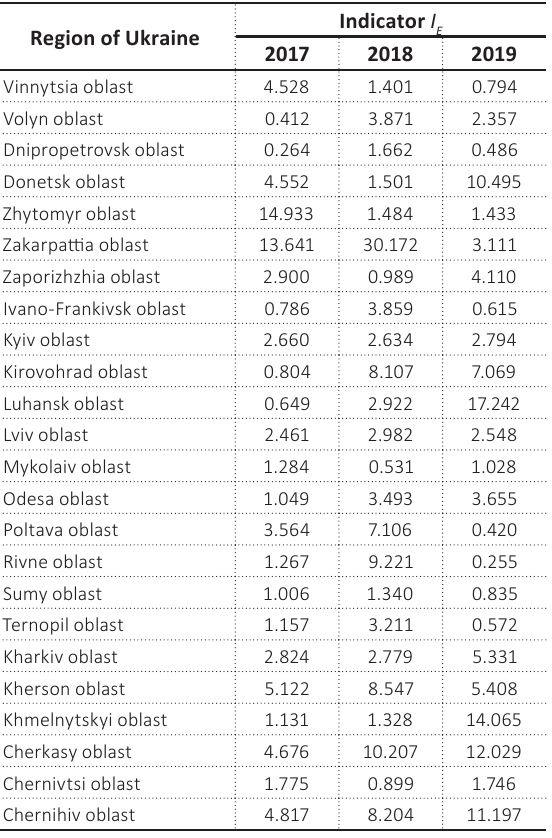
Table 3. Results of calculation of indicators I by regions of Ukraine,